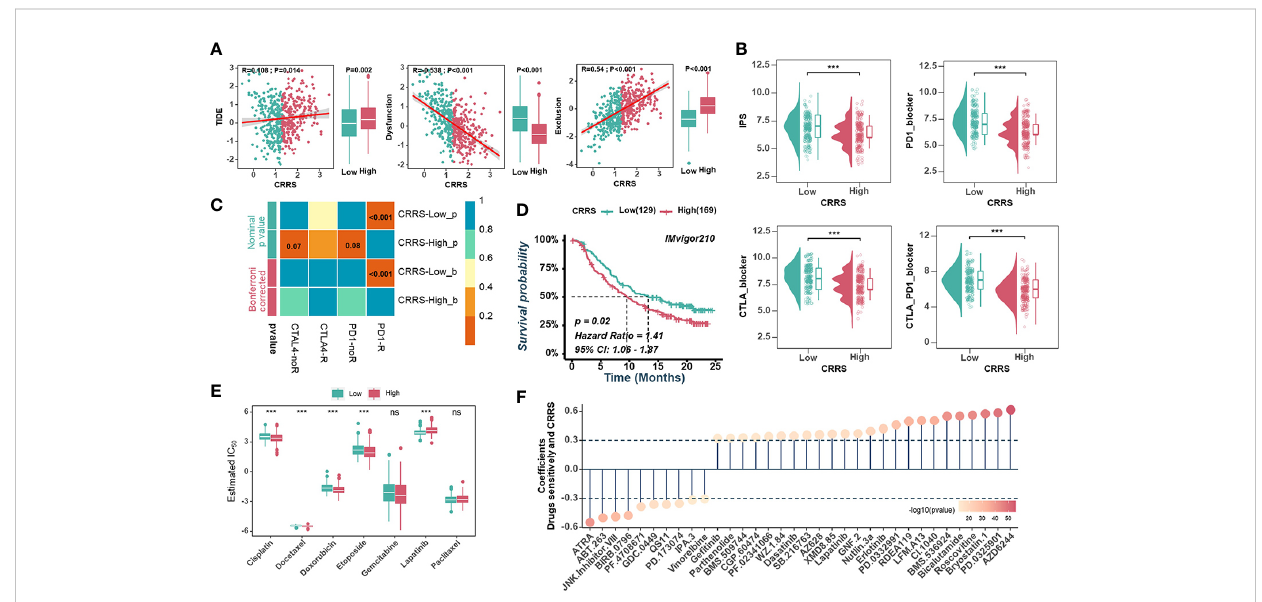
FIGURE 7 Predictive value of CRRS in immunotherapy and chemotherapy. (A) . Scatter plots(left) and box diagrams (right) show the correlations between the CRRS and the TIDE score, dysfunction score, and exclusion score. (B) . The relationship between the CRRS and IPS. (C) . The submap analysis predicts the probability of anti-PD1 and anti-CTLA4 immunotherapy response in low- and high-CRRS groups in the entire cohort. (D) . Kaplan-Meier curves for the IMvigor210 cohort ’ s low- and high-CRRS groups. (E) . Chemotherapeutic sensitivity of 7 common drugs (Cisplatin, Docetaxel, Doxorubicin, Etoposide, Gemcitabine, Lapatinib, and paclitaxel) was estimated and compared. (F) . The bubble chart shows the correlation between CRRS and drug sensitivity. The length of the vertical line indicates the CRRS related to drug resistance (R > 0.3) or drug sensitivity (R < -0.3) to the